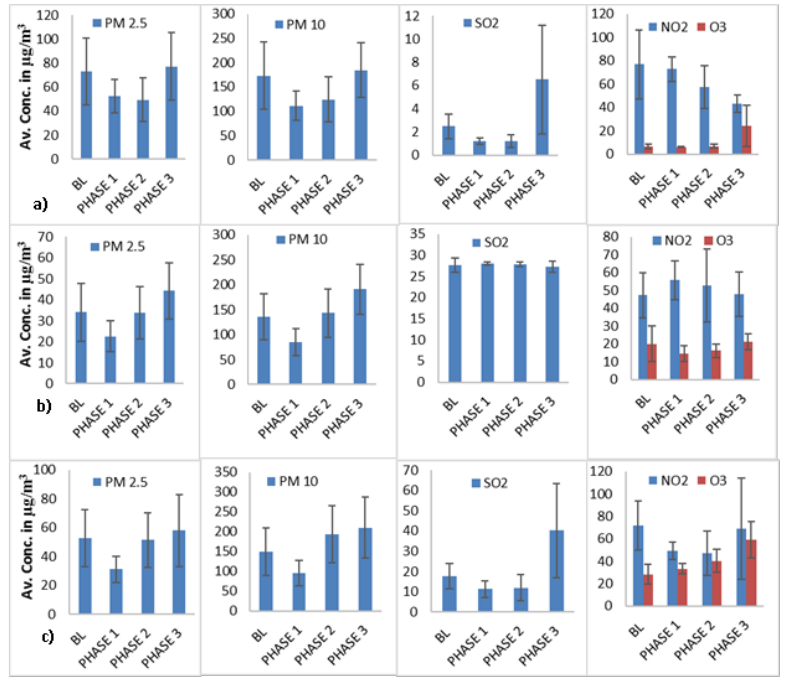
Figure 1. Concentration of PM , PM , SO , NO and O before lockdown and during different 2.5 10 2 2 3 phases of lockdown in 2020 at: (a) Jahangirpuri (b) Sonipat and (c) Panipat (BL - before lockdown (4 th March - 24 th March); Phase 1 (25 th March - 14 th April) when there was complete lockdown; Phase 2 (15 th April - 5 th May) when selected agricultural and industrial activities were allowed; Phase 3 (6 th May - 26 th May) when industrial and construction activities were allowed)